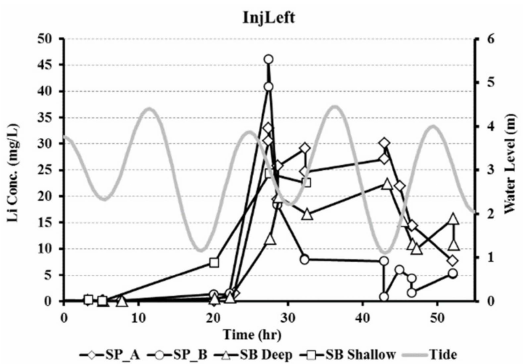
Figure 6. Variation of the concentration at various vertical locations at InjLeft, which was 1.7 m landward of the injection well. The depth of each SP and SB is reported in Table 1.